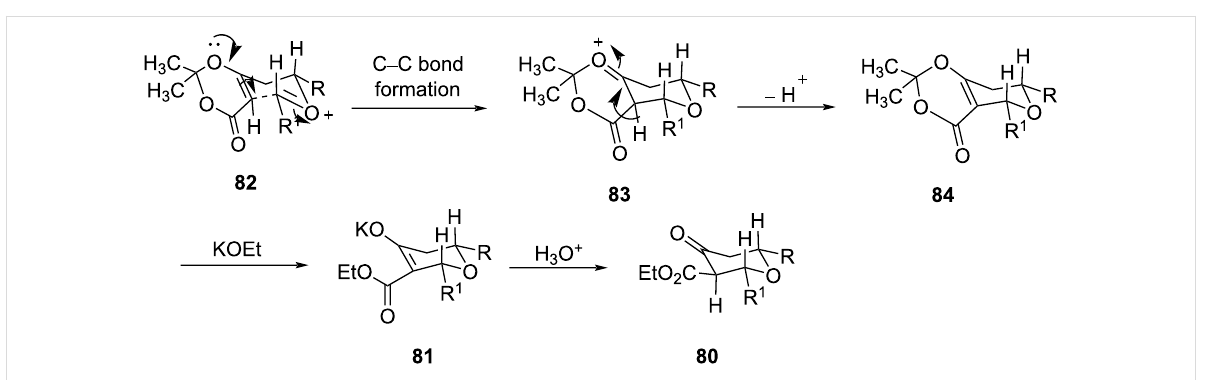
Scheme 17: Scheidt and co-workers’ route to tetrahydropyran-4-one.